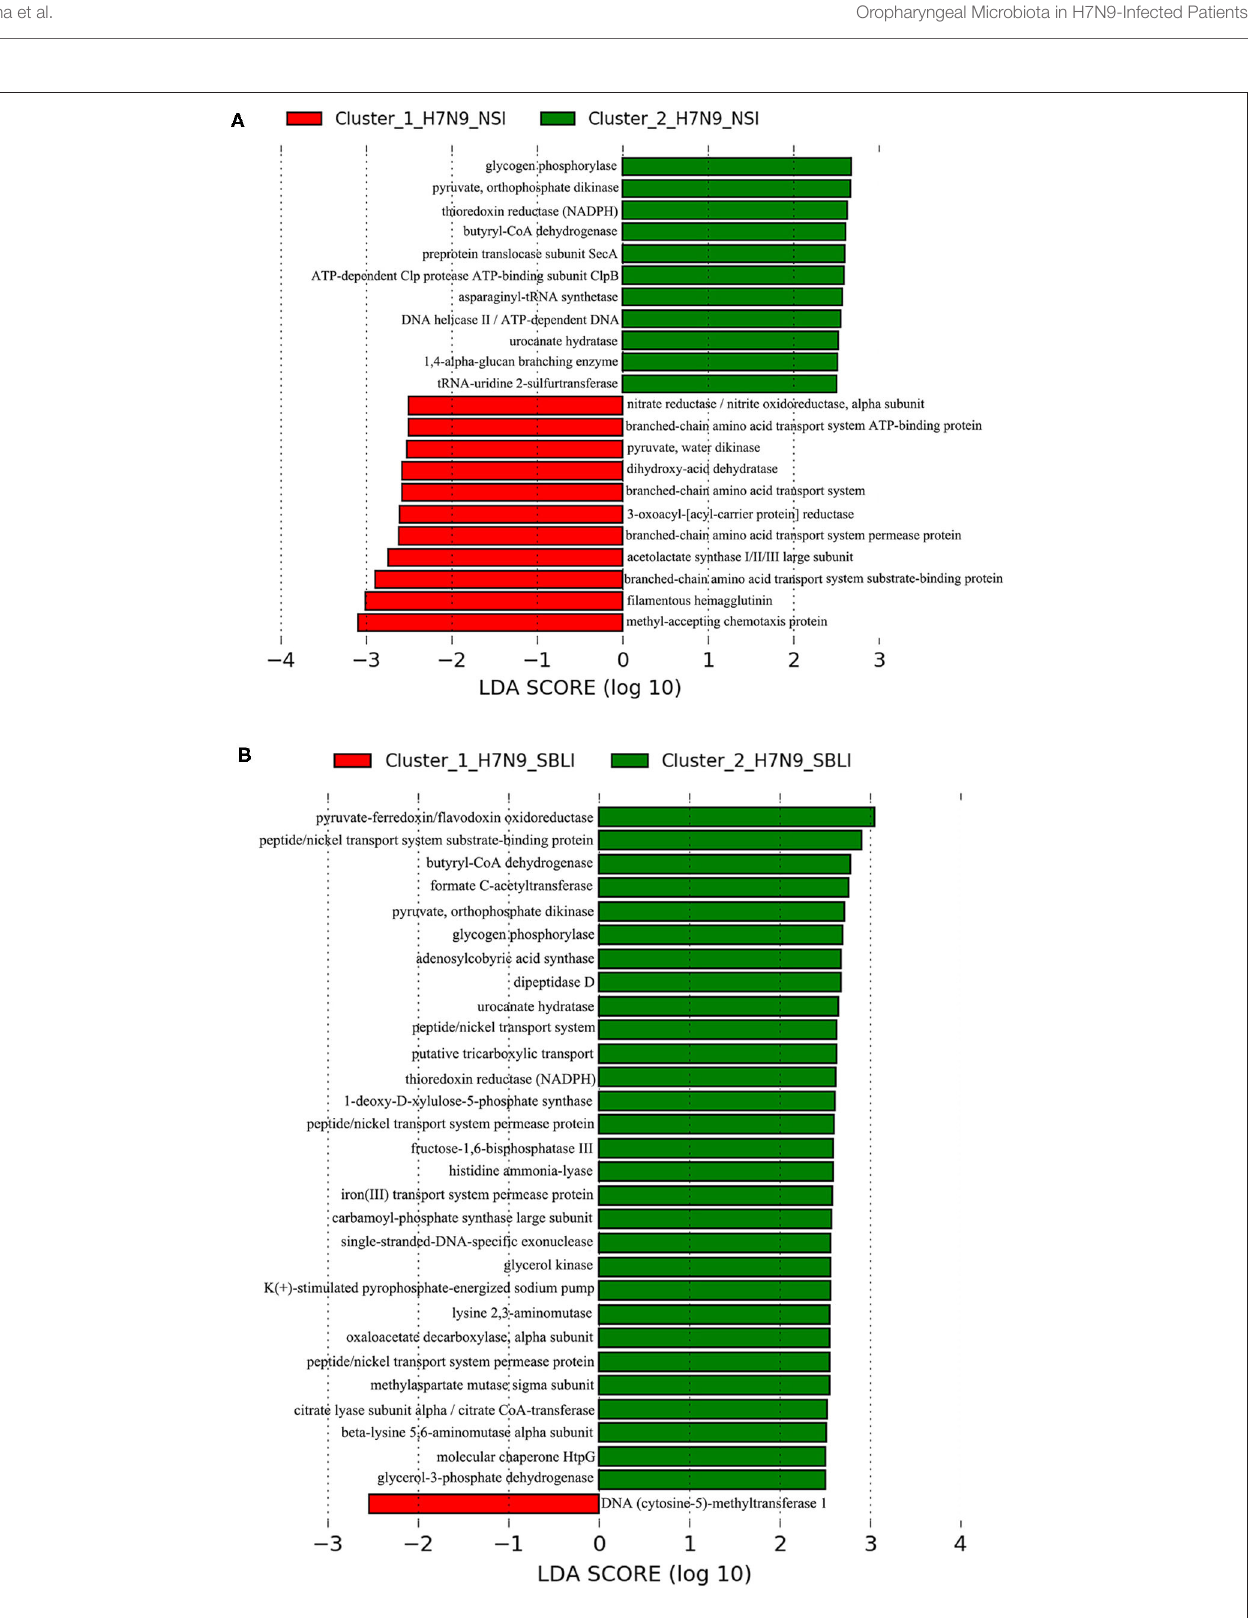
Frontiers in Medicine |